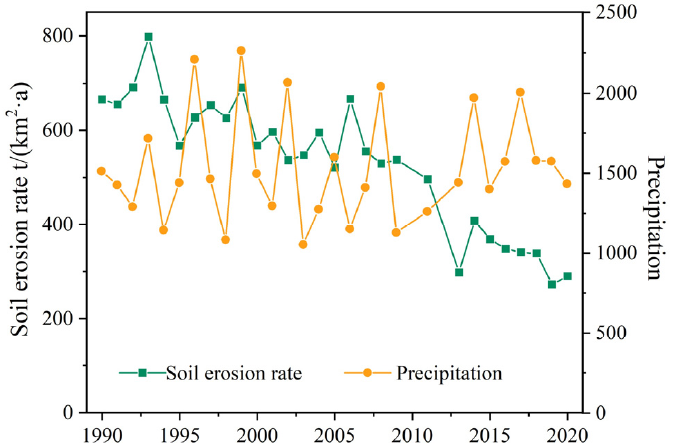
Figure 6. Historical variations in soil erosion and precipitation in the GPRB and its sub-basins in the past 30